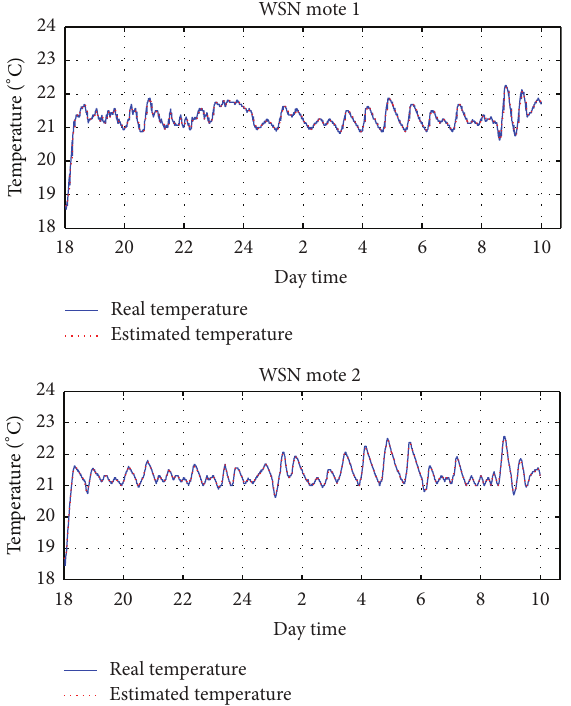
Figure 9: Real and estimated temperature using DES-CC.